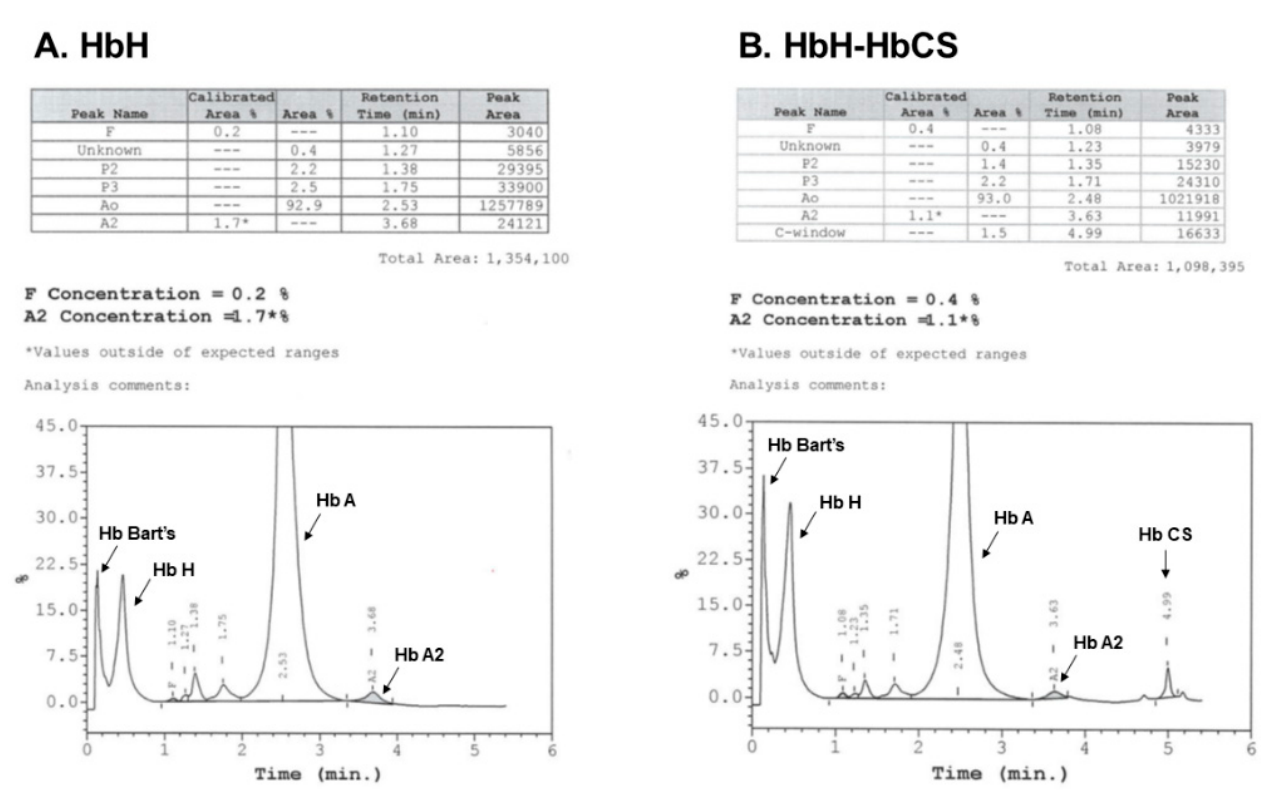
Figure 1. Typical hemoglobin analysis of patients with HbH ( A ) and HbH-HbCS ( B ) by automated high-performance liquid chromatography system.